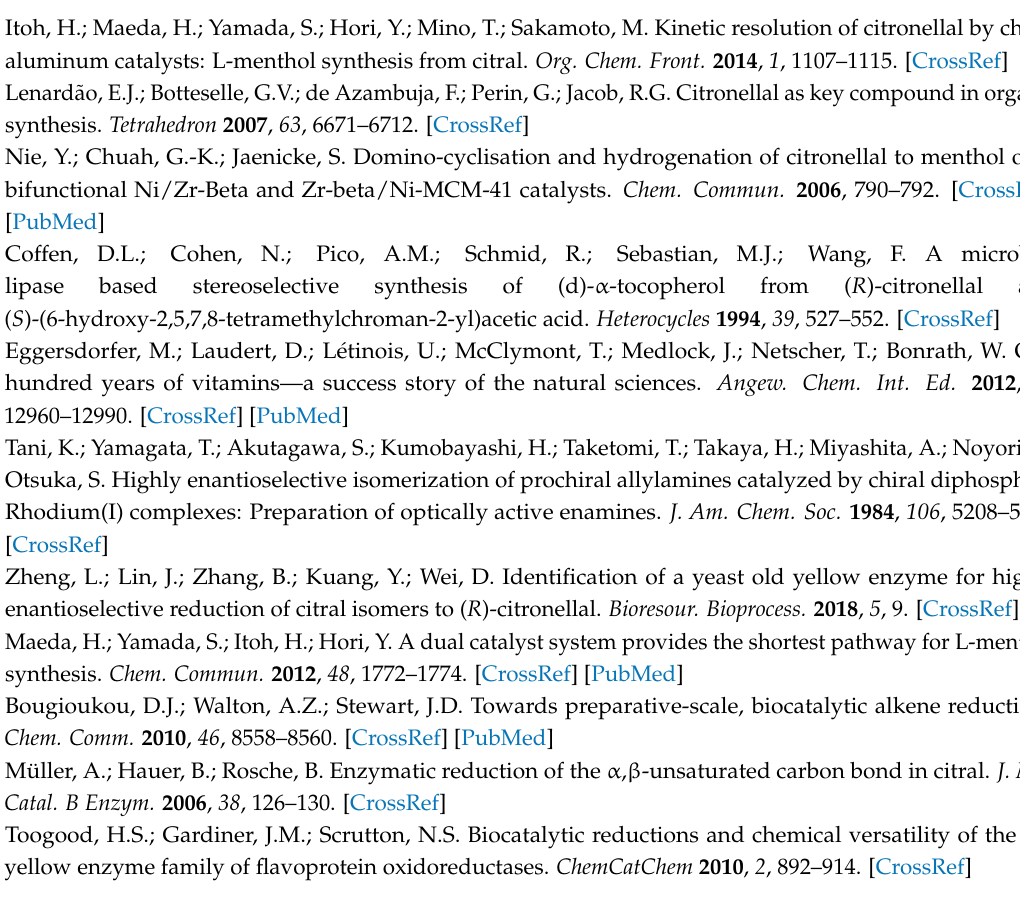
s1, Table S1: The primer information of site saturation mutation of P76 in OYE2y; Table S2: The primer information of site saturation mutation of R330 in Oye2y; Figure S1: SDS-PAGE (12%) analysis of the purified OYE2y R330X variants; Figure S2: SDS-PAGE (12%) analysis of the purified OYE2y P76X variants; Figure S3: Gas chromatography analysis for standards ( S )-citronellal (22.459 min), ( R )-citronellal (23.067 min), ( Z )-citral (29.164 min), and ( E )-citral ( Z )-citral (C), and ( E )-citral (D) in the asymmetric reduction of ( E / Z